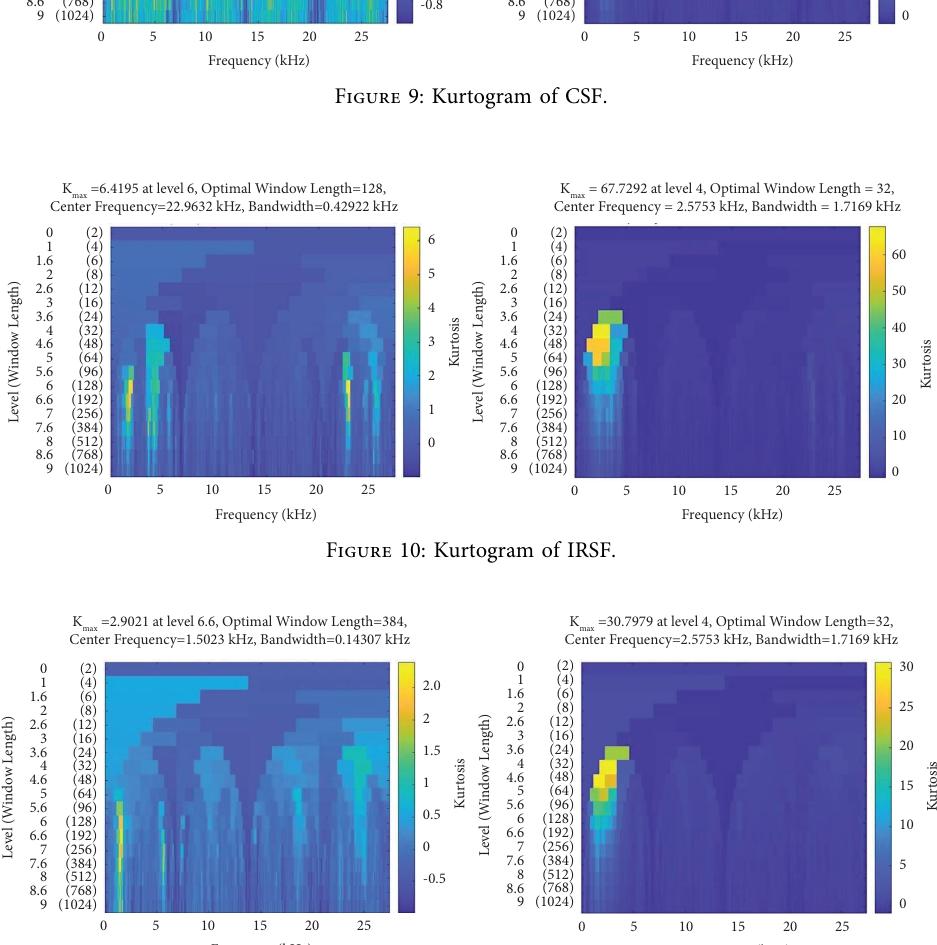
Figure 11: Kurtogram of BMF.